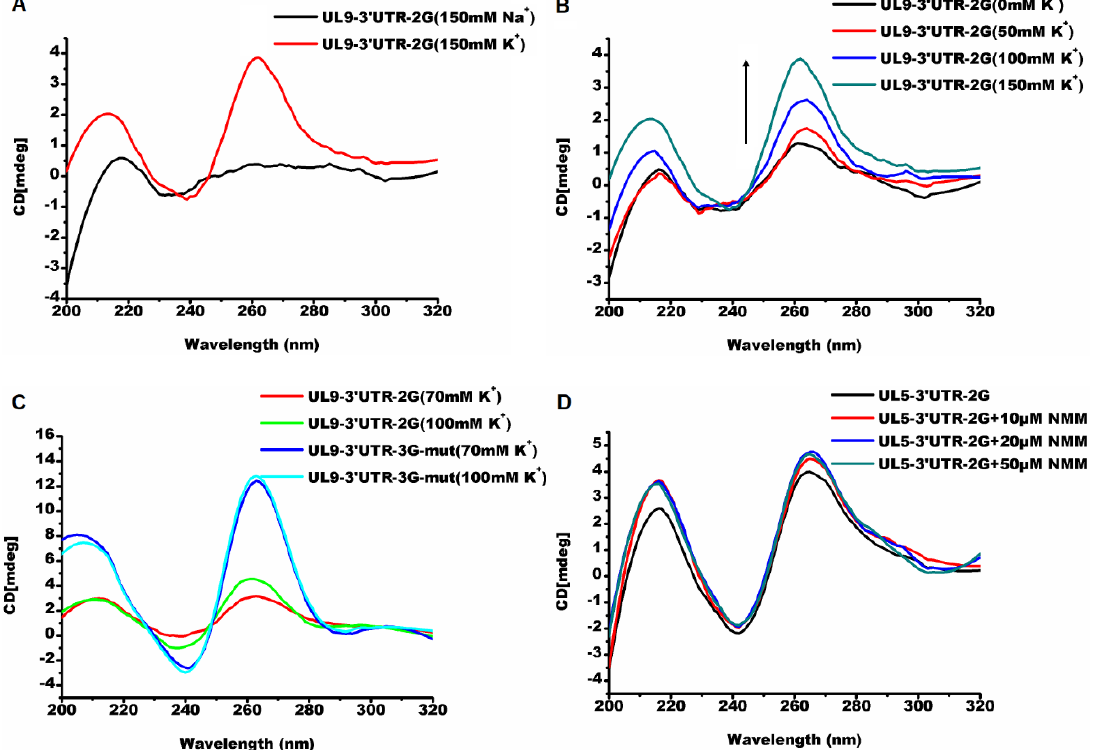
Figure 10. G 2 -PQSs from UL5-3 ′ UTR and UL9-3 ′ UTR are sensitive to cations and ligands. ( A ) CD spectroscopy of the G 2 -PQS (UL9-3 ′ UTR-2G) in the presence of 150 mM NaCl or KCl. ( B ) CD spectroscopy of the G 2 -PQS (UL9-3 ′ UTR-2G) with increasing KCl concentration (0 – 150 mM). ( C ) CD spectroscopy of G 2 -PQS (UL9-3 ′ UTR-2G) and the G 3 -PQS mutant (UL9-3 ′ UTR-3G-mut) with increasing KCl concentration (70 – 100 mM). ( D ) CD spectroscopy of the G 2 -PQS (UL5-3 ′ UTR-2G) with increasing NMM concentration (10 –50 μM).